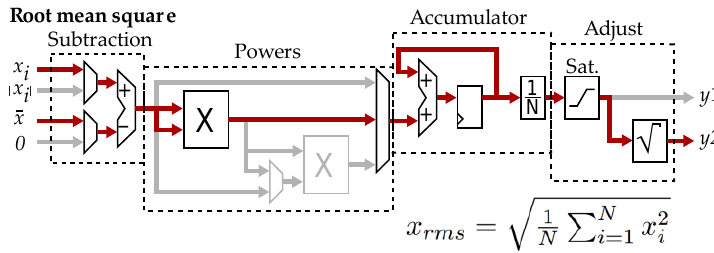
Figure 3. Calculus chain to obtain the root mean square of Equation (3).